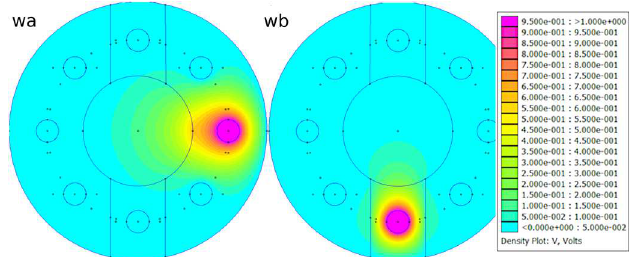
Fig. 17. Weighting potential of two electrodes computed with FEMM on a 2D micro pocket